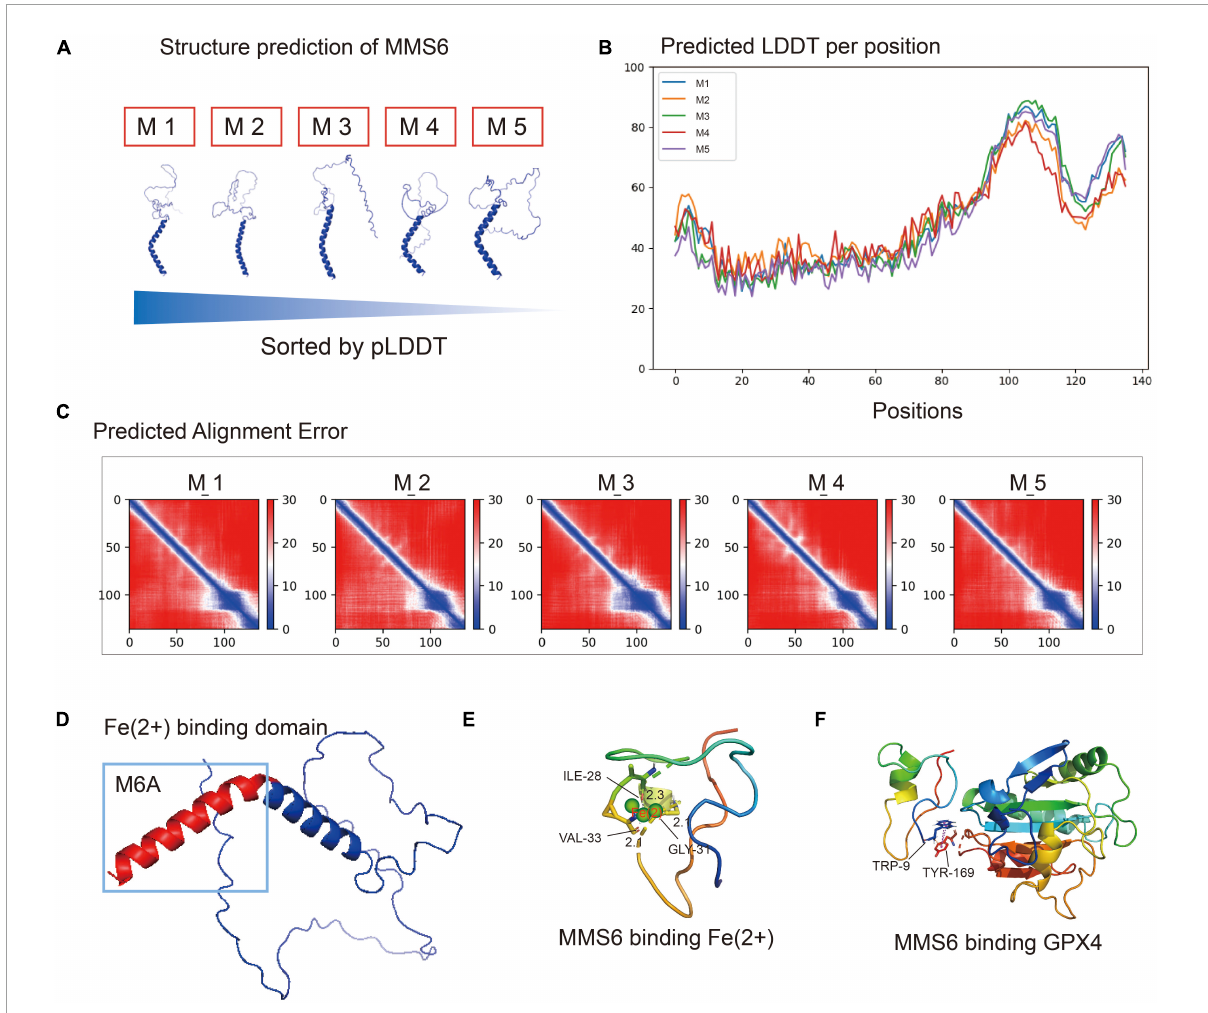
FIGURE5 The MMS6 protein chelates ferrous iron through m6A and interacts with glutathione peroxidase 4 (GPX4). (A) The five protein structure models predicted by Alphafold2 are sorted according to the pLDDT (predicted local distance difference test). (B) Predicted local distance difference test (pLDDT) of each amino acid position in MMS6 protein structure models. (C) Predicted alignment error (PAE) values of five MMS6 protein structure models. (D) The chelating sites of MMS6 and Fe2+are distributed in the M6A sequence at the C-terminal. (E) The N-terminal after the chelation of MMS6 with Fe2+; the β -helices increase and the conformational stability increases. (F) The location where glutathione peroxidase 4 (GPX4) combines with MMS6 may be TRP-9 and